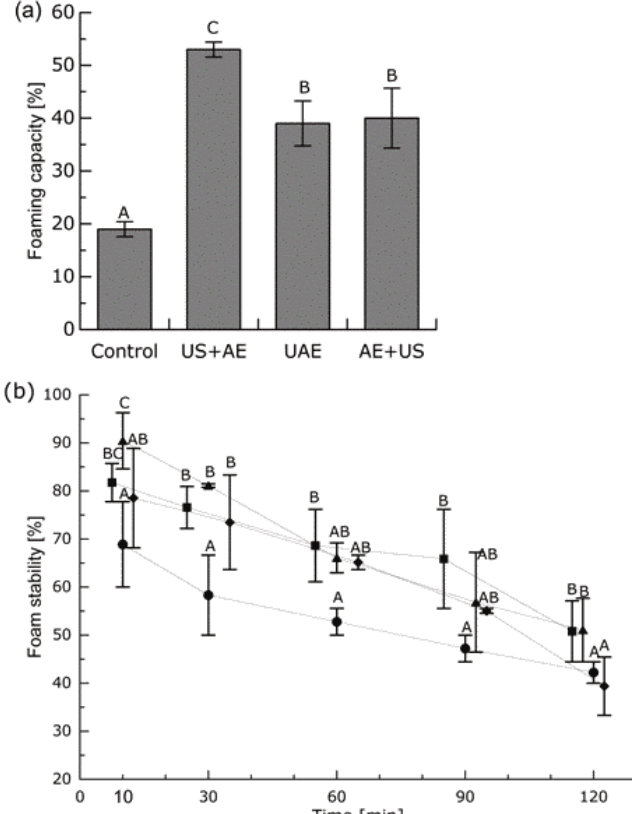
Figure 3. Foaming capacity ( a ) and foam stability ( b ) of protein isolates. Control (circles), alkaline extraction; US+AE (triangles), ultrasonic treatment followed by alkaline extraction; UAE (squares), ultrasonic treatment combined with alkaline extraction; AE+US (rhomboids), alkaline extraction followed by ultrasonic treatment. For better eye guidance, symbols are connected by dotted lines and are slightly shifted along the x -axis. Mean values ± standard deviations ( n = 4) for the same period labeled with different letters differ significantly ( p < 0.05).